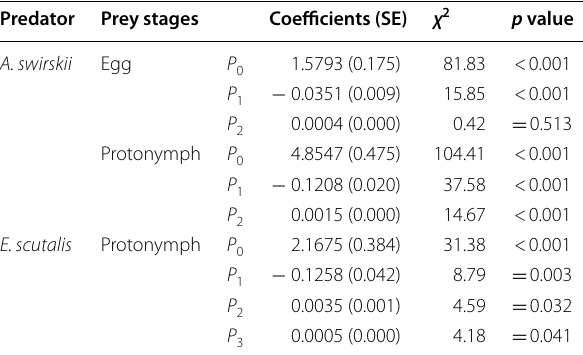
Table 2 Estimated logistic regression coefficients for adult female Amblyseius swirskii and Euseius scutalis feeding on Eutetranychus orientalis egg and protonymph after 24 h at varying prey